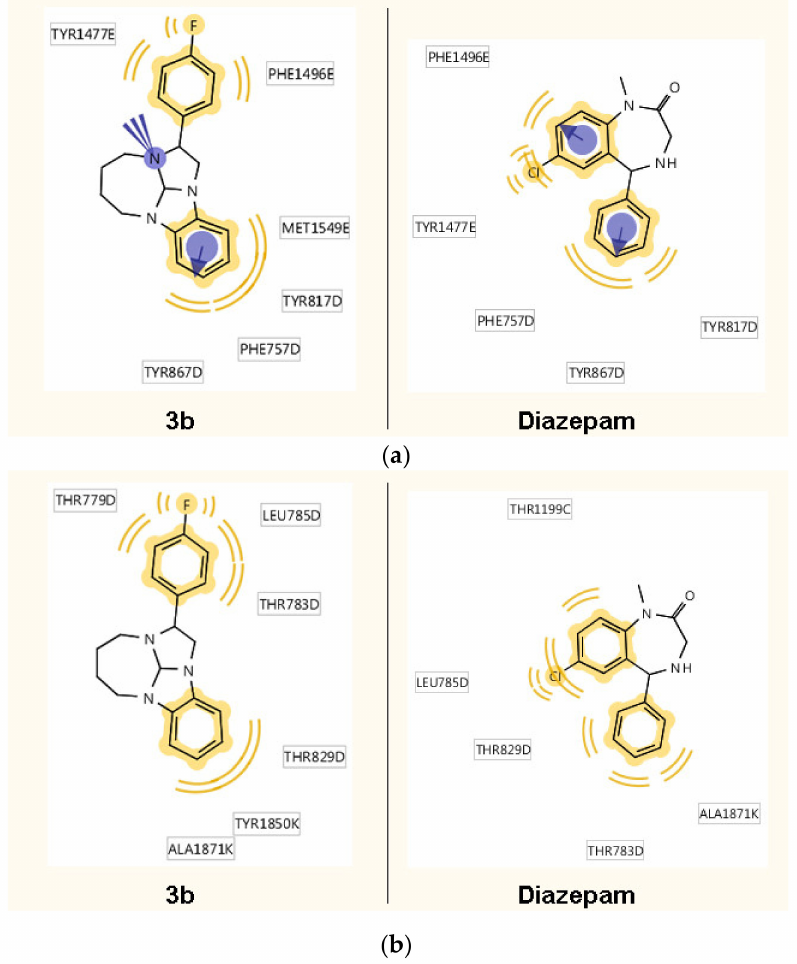
Figure 5. The nature of the binding of compounds in the sites of the GABA A receptor: ( a ) benzodi- azepine site; ( b ) GABA-binding